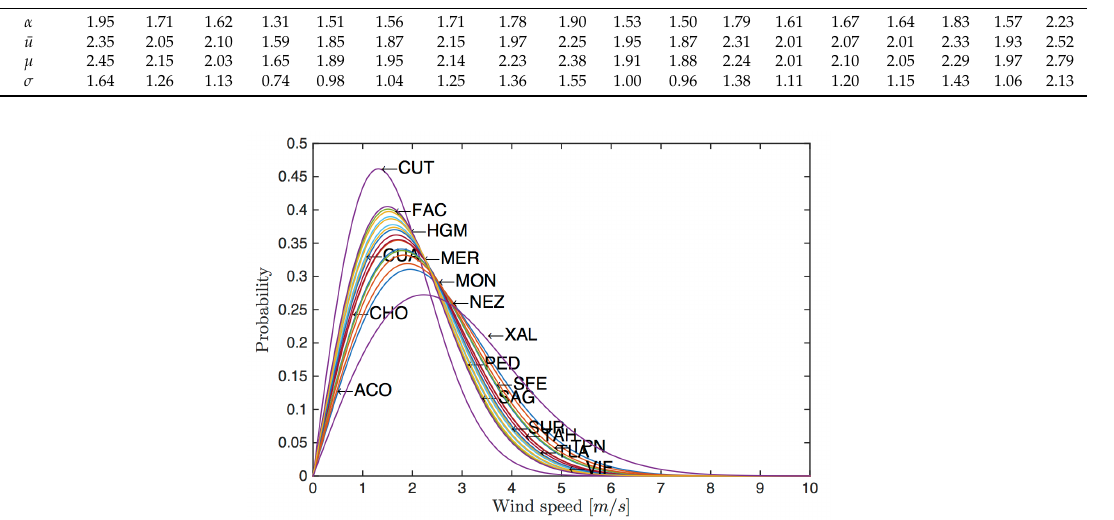
Figure 5. Rayleigh probability distributions fitted to each analyzed